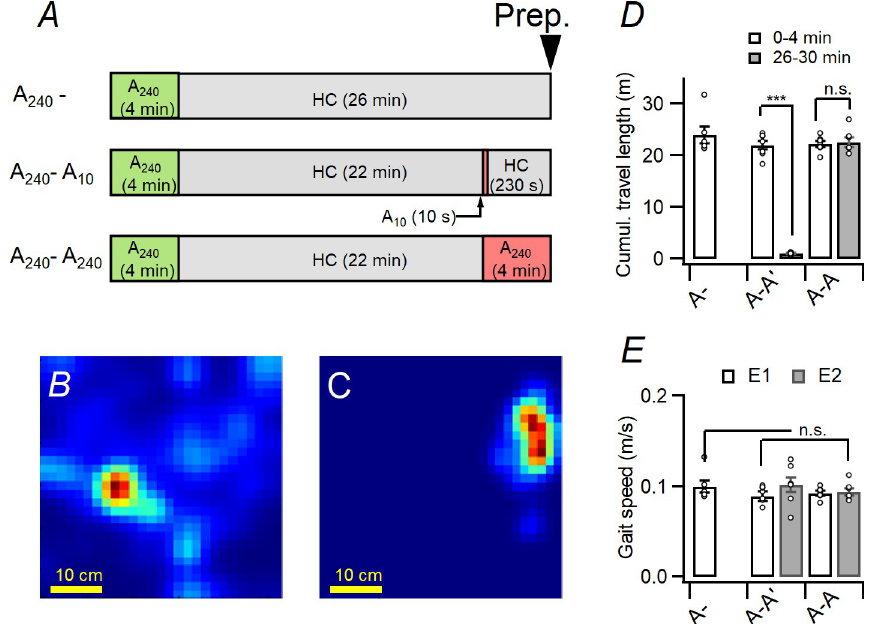
Fig 2. Schematic diagram of contexts and experiment protocol as well as an assessment of animal responses. (A) Schedule of the procedure for cohort A 240 - ( upper ), A 240 -A 10 ( middle ), and A 240 -A 240 ( lower ). For the cohort A 240